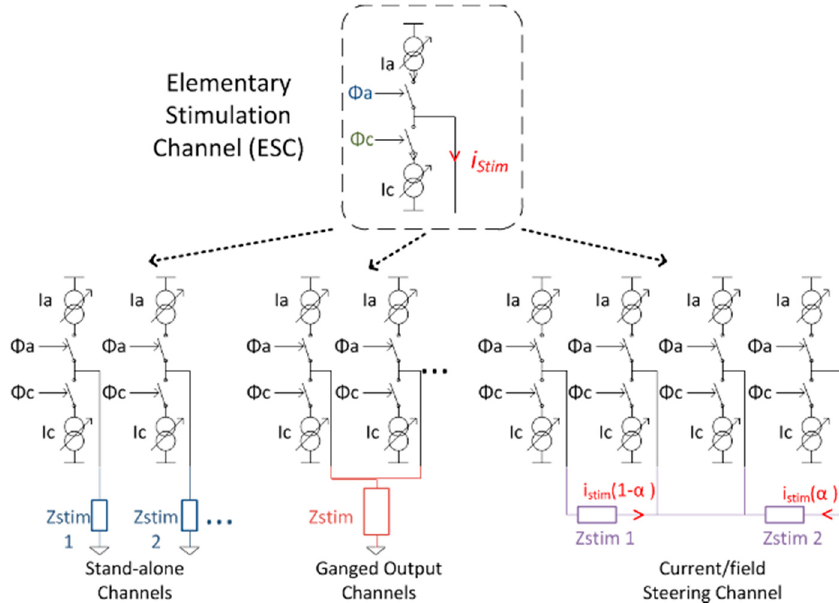
Figure 4. Illustration of the multi-application approach. One Elementary Stimulation Channel (ESC) includes a controlled bidirectional current source to stimulate the smallest electrode with a biphasic waveform. An electrode is represented by Z stim , i stim is the stimulation current. Ic and Ia are current sources; switches are controlled by Fc and Fa. Several ESCs can be associated to provide multi-channel stimulation, stimulation of larger electrode or even complex stimulation schemes such as current steering with multi-polar electrodes; α represents the current steering ratio.